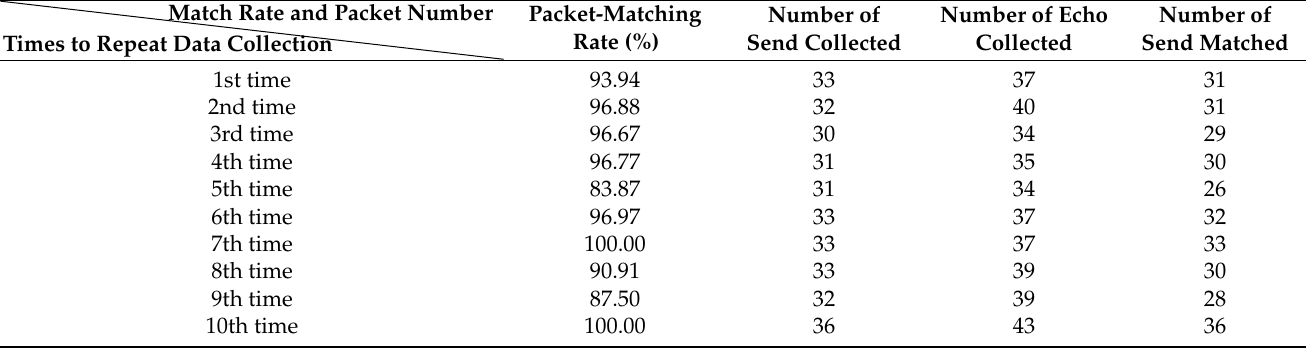
Table 2. Packet-matching rate in one-connection (average rate: